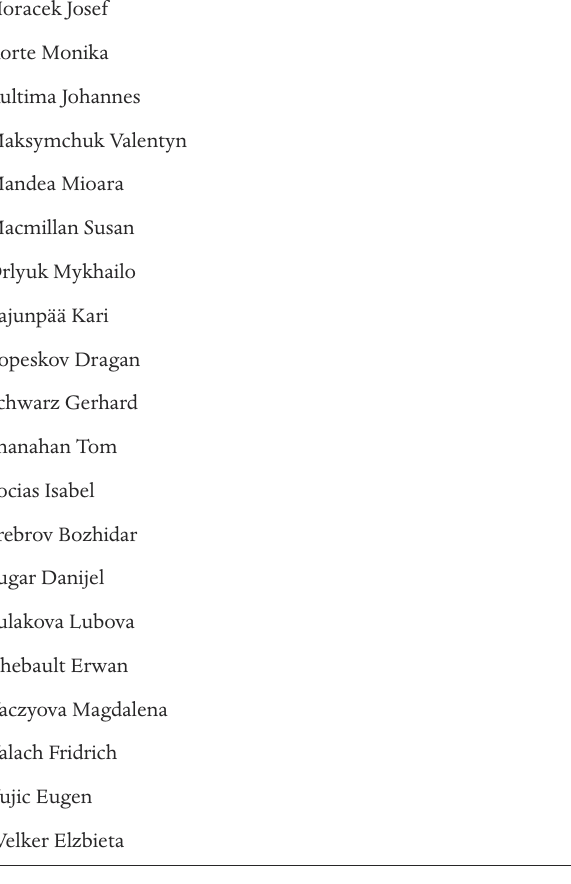
Table 1. Authors of the map and their